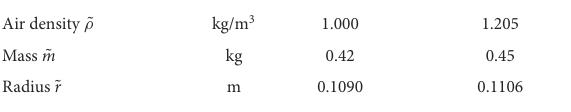
TABLE 3 The range of the uncertain